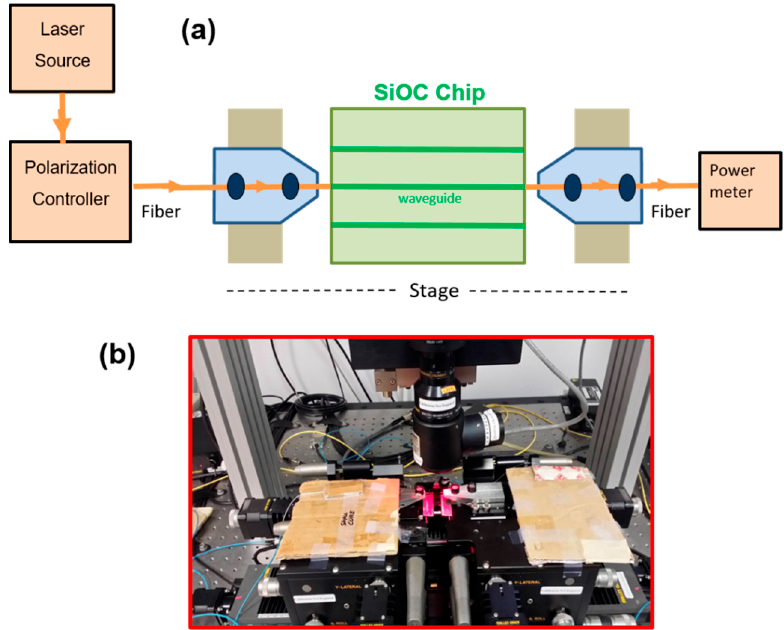
Figure 2. ( a ) Schematic of optical bench setup used for SiOC waveguides characterizations, ( b ) the measurement setup showing alignment of SiOC chip with small core optical fibers.